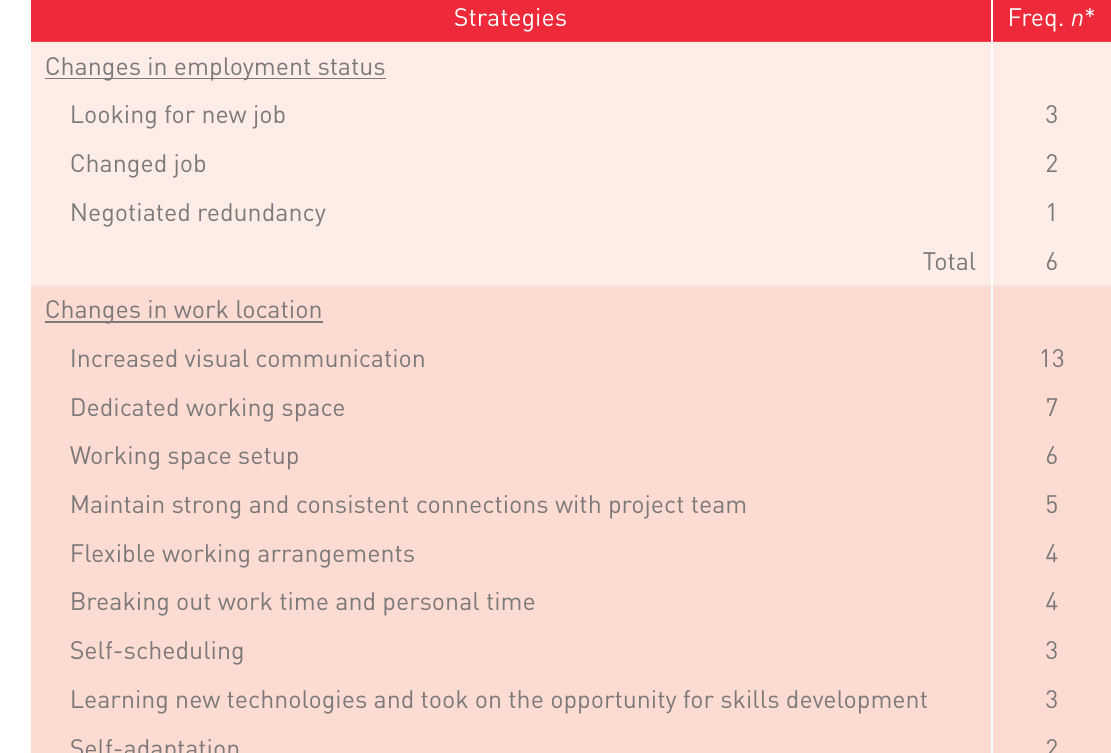
Table 4. The strategies adopted to overcome the challenges associated with the changes in the respondents’ job situations during the pandemic Strategies Freq. n